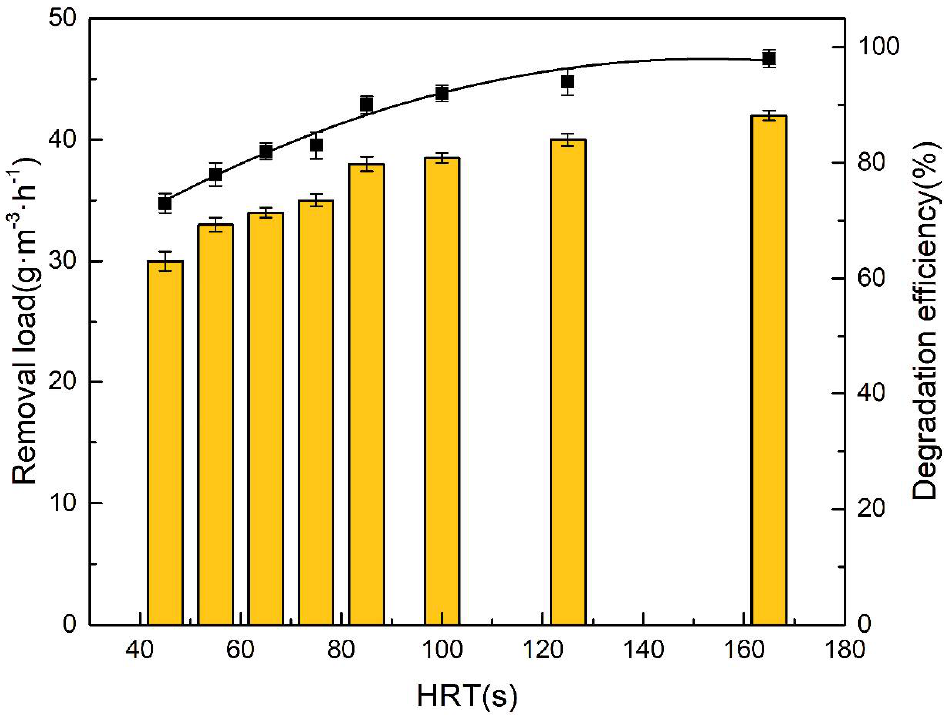
Figure 4. Influence of HRT on degradation efficiency and removal loadings of BTF. ( ■ Degradation efficiency, ■ Removal load) (Air inlet gas flow = 2000 mL·min −1 , nutrient spray density = 5.17 L·(m −3 ·s −1 ), oxygen concentration = 10%, pH = 6.5–7.0).